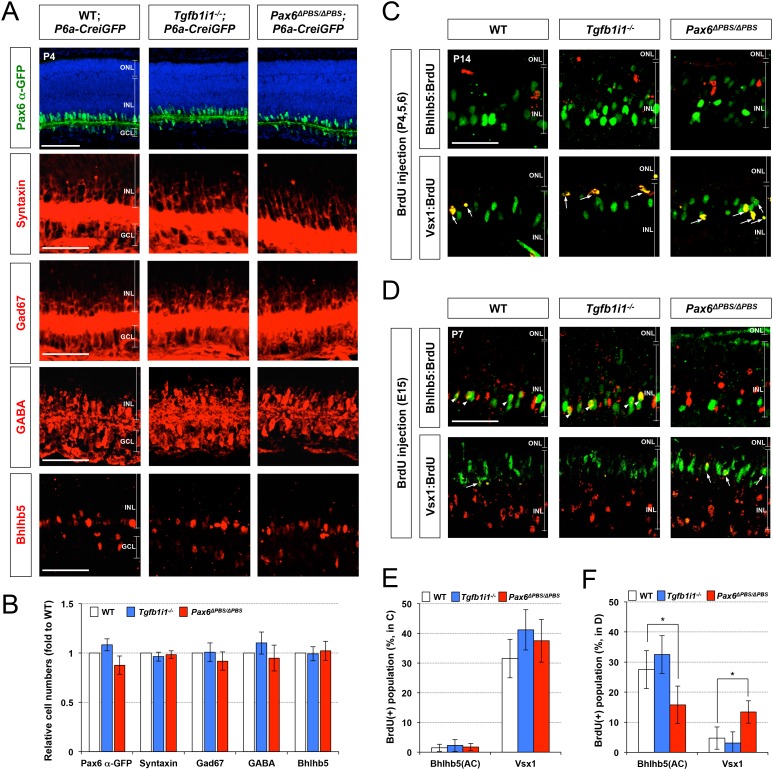
Fate determination of GABAergic amacrine cells and OFF bipolar cells in the post-natal mouse retinas.(A) The effects of deletions of Tgfb1i1 (Tgfb1i1−/−) and PBS sequence of Pax6 α-enhancer (Pax6ΔPBS/ΔPBS) on GABAergic amacrine cell development were investigated by immunostaining of various GABAergic amacrine cell markers, including Gad67, GABA, and Bhlhb5. Distribution of entire amacrine cells was examined by immunostaining of pan-amacrine cell marker Syntaxin. The effects of the gene deletions on Pax6 α-enhancer activity was also determined by detecting cells expressing Pax6 α-GFP. Scale bars, 100 μm (top) and 50 μm (rest). (B) Relative numbers of marker-positive cells in P4 Tgfb1i1−/−and Pax6ΔPBS/ΔPBS mouse retinas are determined by comparing with those in their WT littermate mice. Error bars denote STD (n = 4, two independent litters). *p<0.05. (C) To identify the fate of cells were born in WT, Tgfb1i1−/−, and Pax6ΔPBS/ΔPBS between post-natal day 4 and 7 (P4 and P7) when bipolar cells and Müller glia are predominantly generated, the mice were repeatedly injected with BrdU (5 mg/kg) at P4, P5, and P6. Eye sections of the BrdU-injected mice were obtained at P14 for the immunodetection of Bhlhb5-positive GABAergic amacrine cells and Vsx1-positive OFF bipolar cells, which had exited cell cycle after incorporating BrdU between P4 and P7. Scale bar, 50 μm. (D) To trace the fates of cells produced in the embryonic retina when amacrine cells are generated, pregnant mice were injected with BrdU (5 mg/kg) at 15 dpc (E15) and the identities of cells had exited cell cycle after incorporating BrdU were examined at P7. Scale bar, 50 μm. (E and F) BrdU-labeled cell population in Bhlhb5-positive GABAergic amacrine cells, which locate the bottom half of INL, and that in Vsx1-positive OFF bipolar cell population in P14 mouse retinas as (C) and P7 mouse retina as (D) are quantified. Values in the Y-axis are average and error bars denote STD (n = 4, two independent litters). *p<0.05.